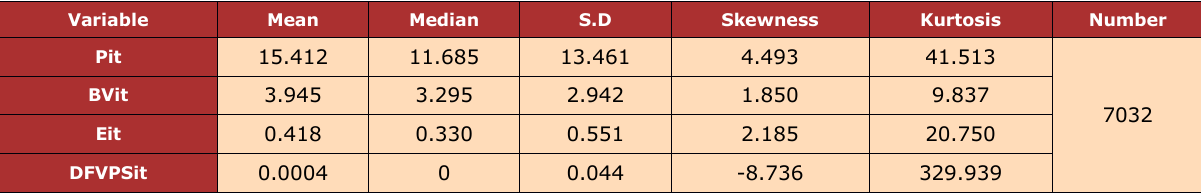
Table 3. Descriptive statistics